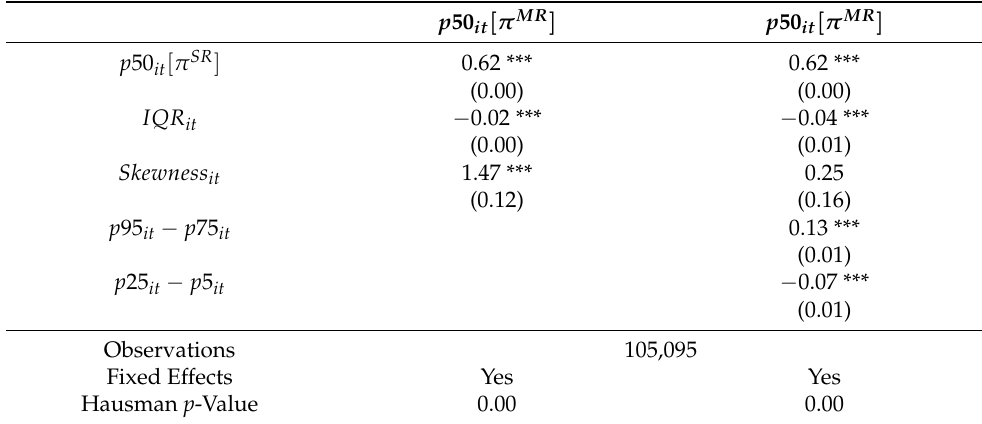
Table 2. The table shows the results from regression Equations (4) and (5). The results show that longer run expectations increase with the skewness of short run distributions—as perceived risks become weighted to the upside—and with the tails—as perceived inflationary and disinflationary risks become more extreme—of the short run